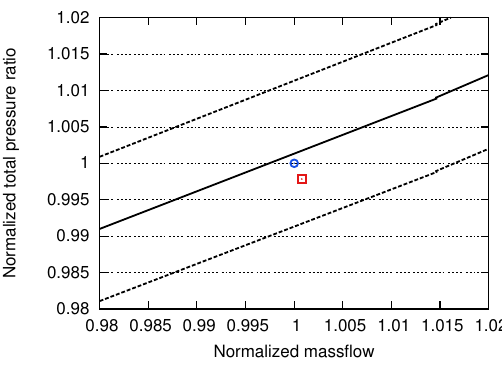
Figure 6. Performance of the simulated stages normalized by the axisymmetric values: blue circle for the axisymmetric operating point, red square for the asymmetric one, experimental operating line in solid black line and limits of the ± 1% error region in dotted black